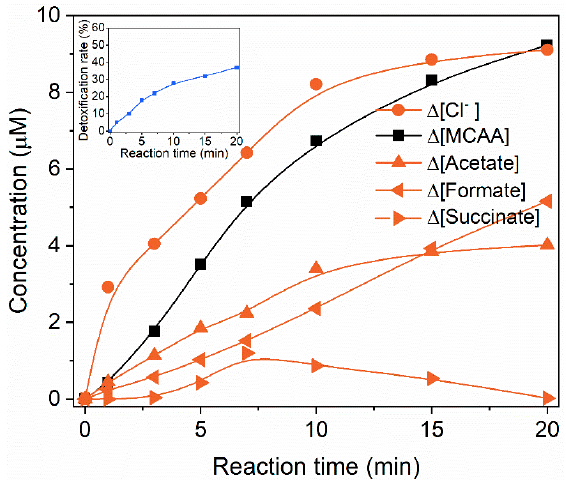
Figure 10. Concentration variation of MCAA ( Δ [MCAA]) and its degradation products with an insert showing the detoxification efficiency. Conditions: [BiOI] 0 = 1.0 g ⋅ L − 1 (84.9 μ M as I); [S(IV)] 0 = 1.0 mM; [MCAA] 0 = 10 μ M; [DO] 0 = 0.22 mM (7.1mg ⋅ L − 1 ); pH = 7.0, 25 ± 1 °C.